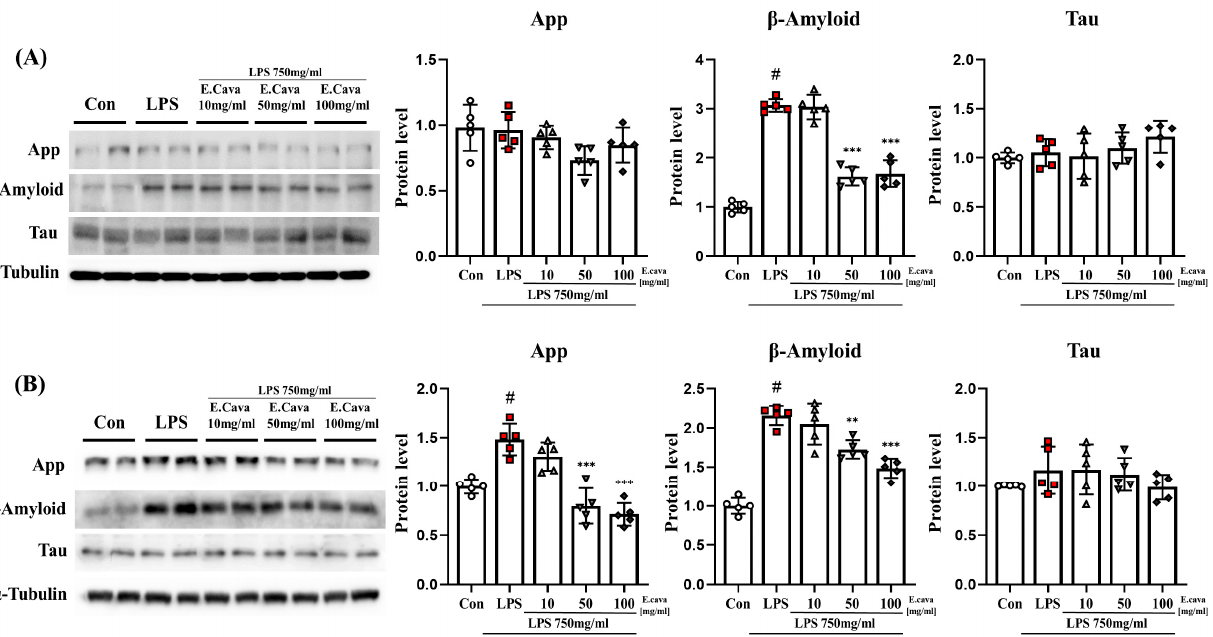
Figure 6. E. cava reduces Alzheimer’s disease-related markers in the mouse brain. ( A ) Western blot analysis and quantification of neurodegenerative disease-related genes were evaluated in the cerebrum of each group of male mice. ( B ) Western blot analysis and quantification of Alzheimer’s disease-related genes were evaluated in the hippocampus of each group of male mice. Alpha-Tubulin was used for internal control. The points on the graph are represented by different shapes, with a white circle indicating the control group, a red square indicating the LPS group, a triangle representing the LPS + E. cava 10 mg/kg group, an inverted triangle indicating the LPS + E. cava 50 mg/kg group, and a rhombus representing the LPS + E. cava 100 mg/kg group. The differences between means were obtained through one-way ANOVA, and then a Tukey post-analysis. The values represent means ± S.D. # p < 0.001 vs. control group and ** p < 0.01, *** p < 0.01 vs. LPS